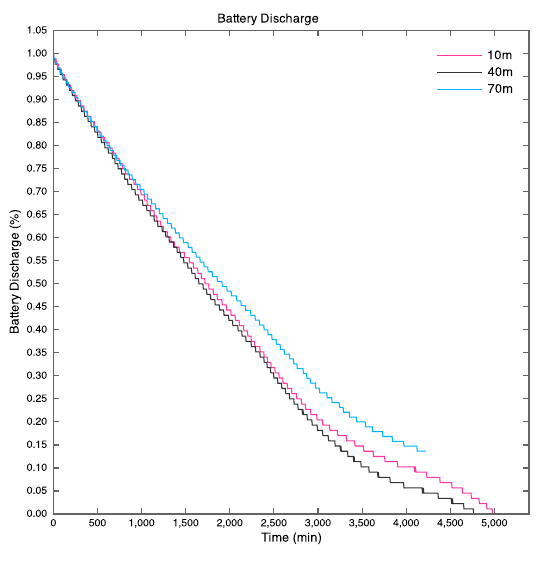
Figure 11. Battery Discharge Curves for Experiment 2.